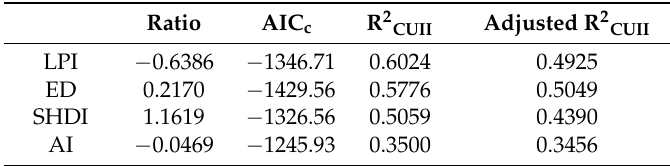
Table 9. Change ratio and the parameters of the soil landscape metrics in GWR.